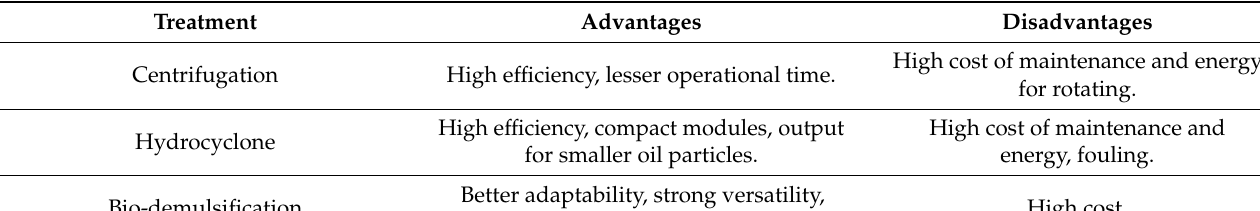
Table 11. Summary of oil–water emulsions separation